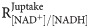
The role of the short-chain branch.(A) Steady-state flux versus [palmitoyl-CoA]CYT in the published model (black line), a model without any enzymatic promiscuity (black dashed line, reproducing results from [8] as a reference), a model without promiscuity of MCKAT (green line), and finally a model with only promiscuity of MCKAT, but not of any of the other enzymes (purple line). (B) The flux control coefficients in the original model as a function of [palmitoyl-CoA]CYT. Only enzymes with a substantial contribution are included; for a complete set of flux control coefficients, see figure A in S2 Fig. (C-D) Top 15 flux response coefficients with the highest absolute values at 25 μM (C) and 60 μM (D) of [palmitoyl-CoA]CYT. The parameters p for which the flux response coefficient was calculated is indicated on the Y-axis. Dark grey bars represent CPT1-related parameters, pink bars represent M/SCHAD-related parameters, purple bars represent MCKAT-related parameters and the light blue bar represents a crotonase-related parameter. (E) Flux response coefficient of [NAD+]/[NADH] (R[NAD+]/[NADH]Juptake) partitioned in contributions of individual NAD+-dependent reactions at 5 palmitoyl-CoA concentrations according to R[NAD+]/[NADH]J=∑iCiJ∙ε[NAD+]/[NADH]vi. (cf. Eq 4). The contributions of M/SCHAD reactions C8-C16 to R[NAD+]/[NADH]Juptake were negligible and therefore not shown in the legend.